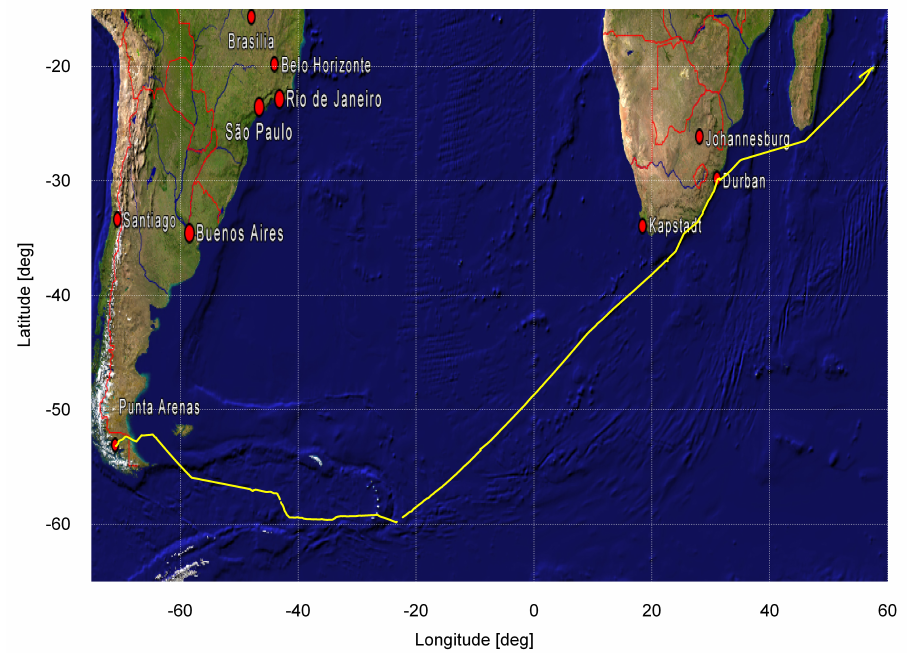
Fig. 1. The Marion Dufresne cruise track over the South Atlantic